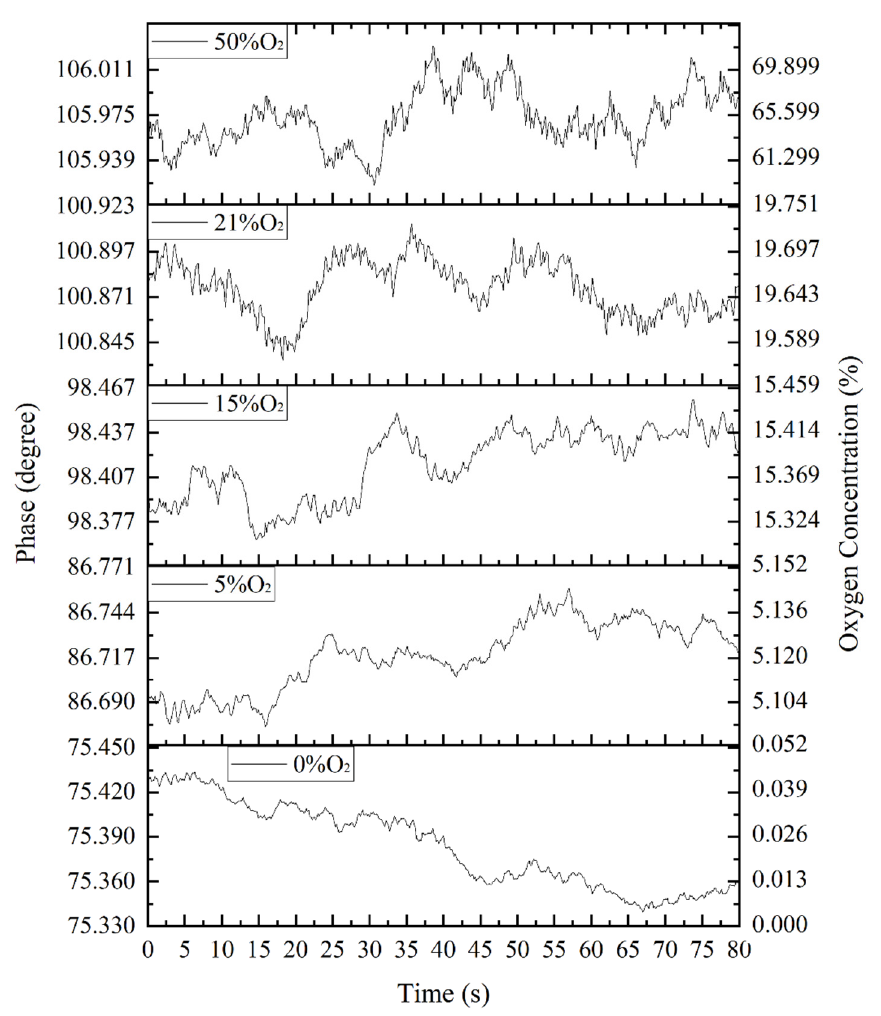
Figure 12. The results of multiple detections by the sensor under various oxygen concentrations.